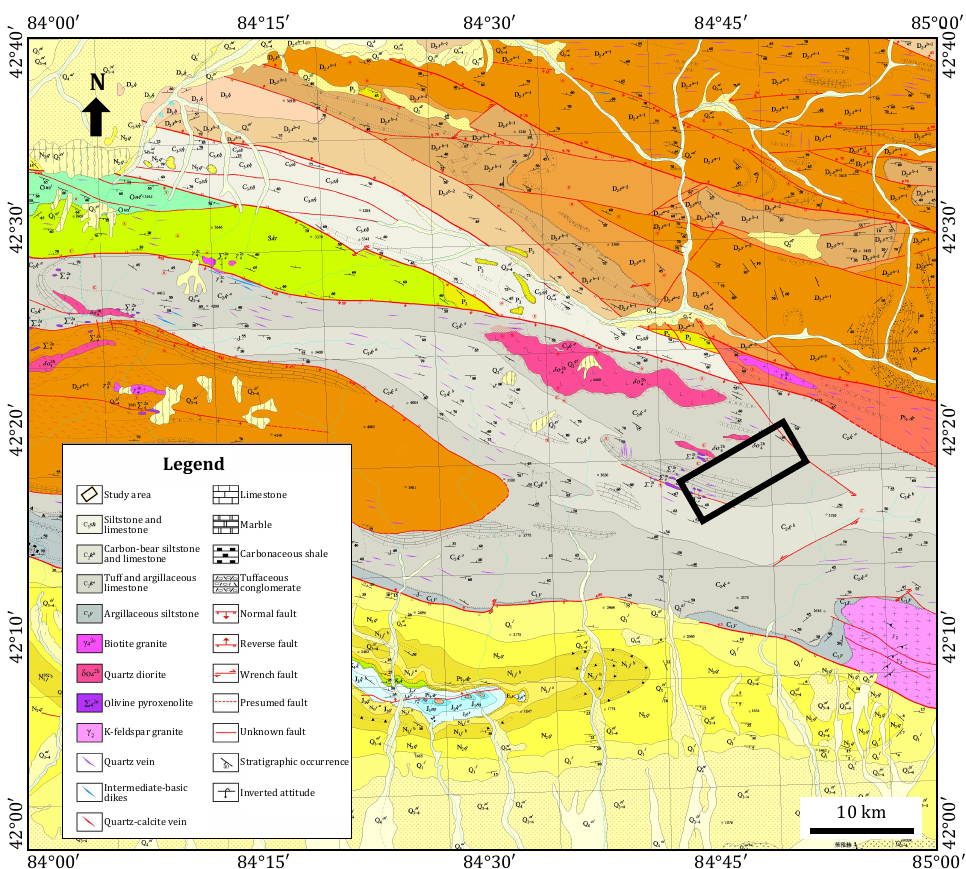
Figure 1. Location map and geological background of Huola Mountain. The regional strata mainly consist of Paleoproterozoic (Pt1Ar), Devonian (D), Car- boniferous (C), Neogene (N), and Quaternary (Q) materialsin the Huola Mountain Tunnel area. According to previous regional geological data, Huola Mountain Tunnel is crosscut by five faults (numbered F1 to F5, respectively) [26]. The four E–W-trending faults are nearly parallel. The F4 and F5 faults are crosscut by the F3 NW–SE trending strike-slip fault with about 300 m strike-slip distance. The F1 fault mainly occurs in the contact zone between the Carboniferous and the Quaternary strata. The F2 fault is present within the Carboniferous strata. The F3–F5 faults are present in the contact zone between the Carboniferous, Devonian, and Precambrian strata. The core Early Carboniferous strata is a uniform shallow marine carbonate sedimentary formation